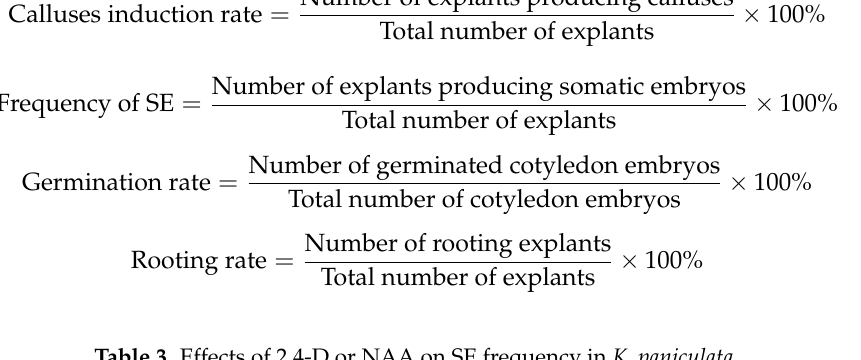
Table 3. Effects of 2,4-D or NAA on SE frequency in K. paniculata